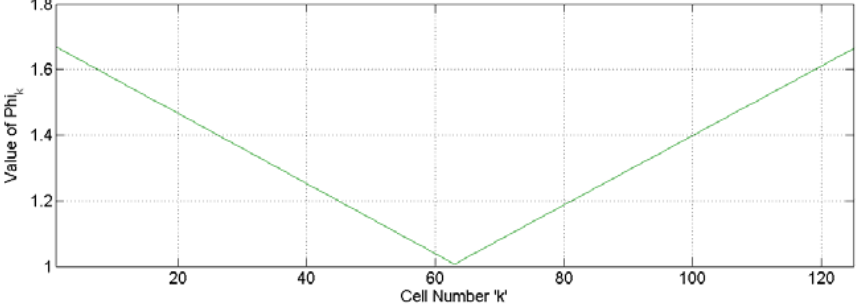
Figure 6. The values of φ k for different cells (VRB).